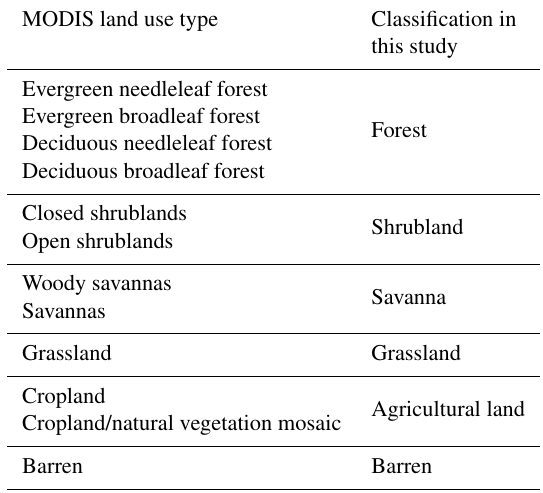
Table 1. Subcategories of land use types as defined by